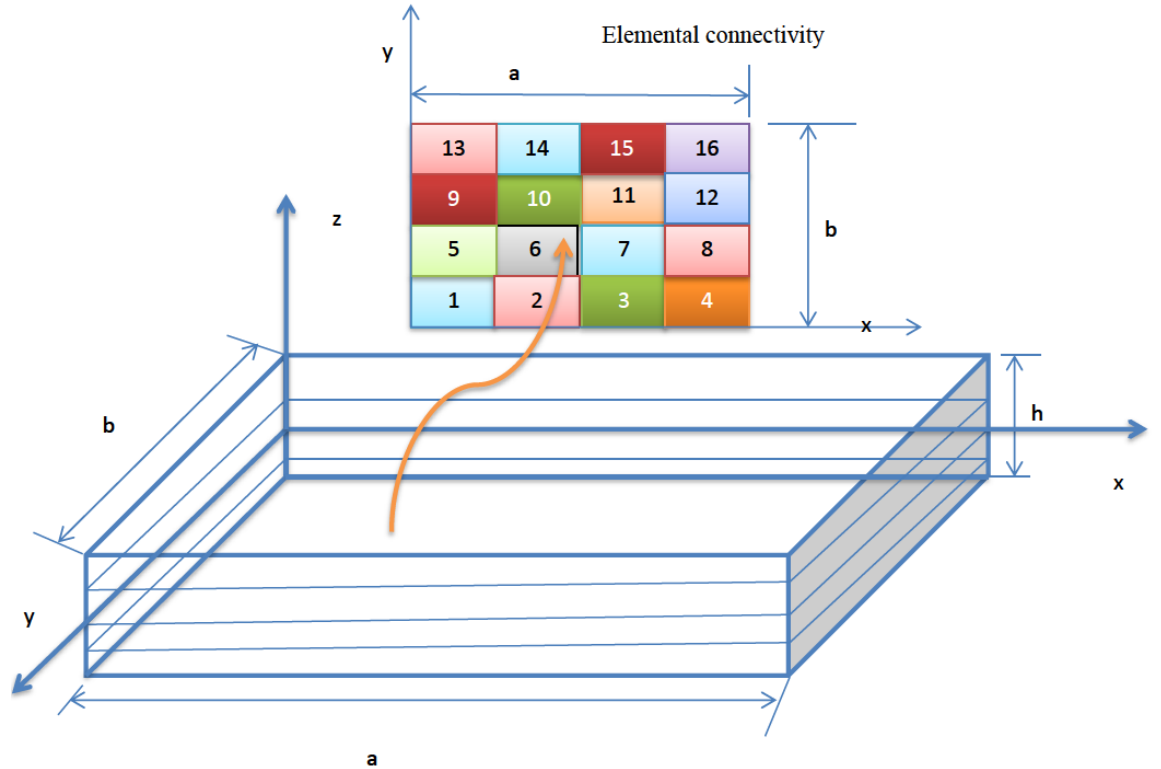
Figure 3: Laminated SWCNTRC-FG composite plate discretised into 4X4 nine noded isoperimetric